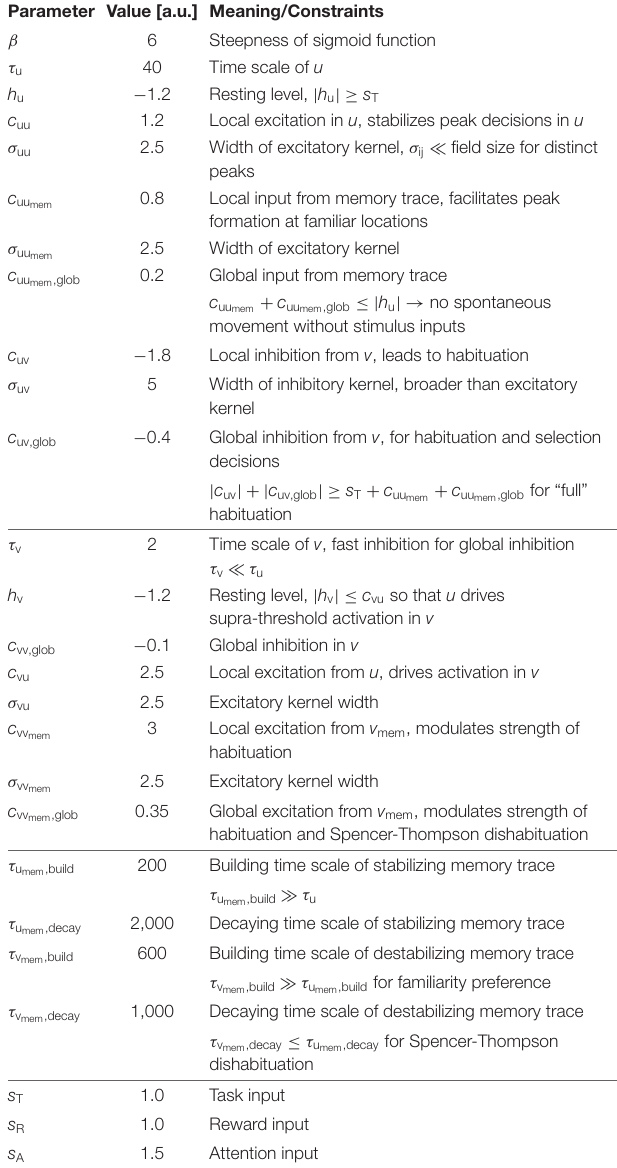
TABLE 1 | Parameter values of the habituation